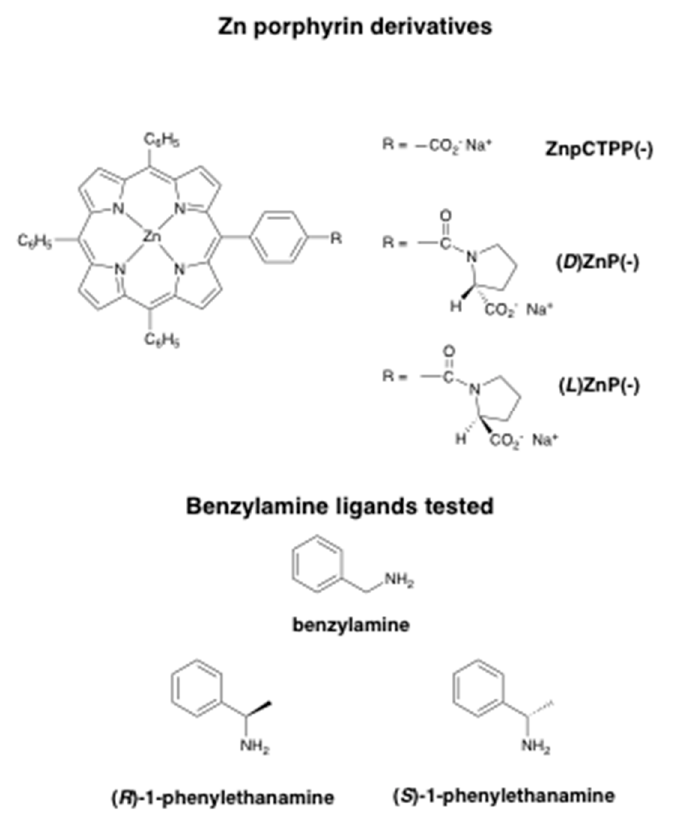
Chart 1. Molecular structures of porphyrin and benzylamine derivatives studied in this